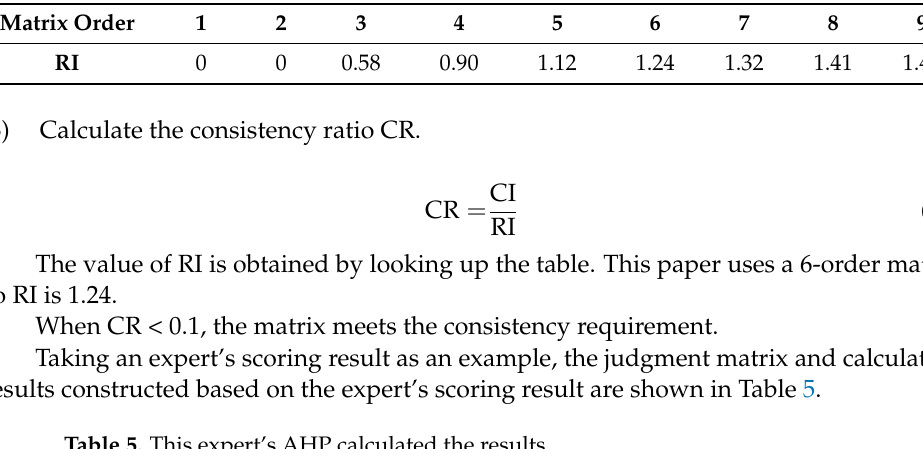
Table 4. AHP average consistency index value table (adapted from